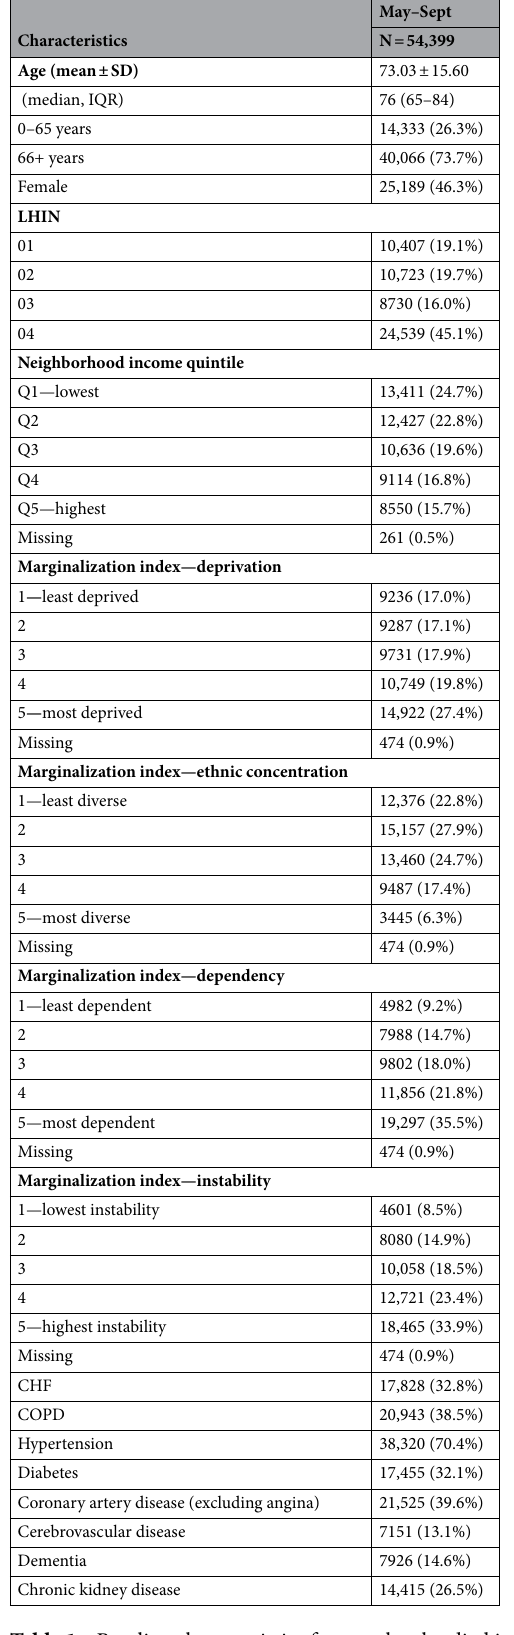
Table 1. Baseline characteristics for people who died in Southwestern Ontario between 2005 and 2012. CHF congestive heart failure, COPD chronic obstructive pulmonary disease, LHIN Local Health Integration Network, SD standard deviation, IQR interquartile